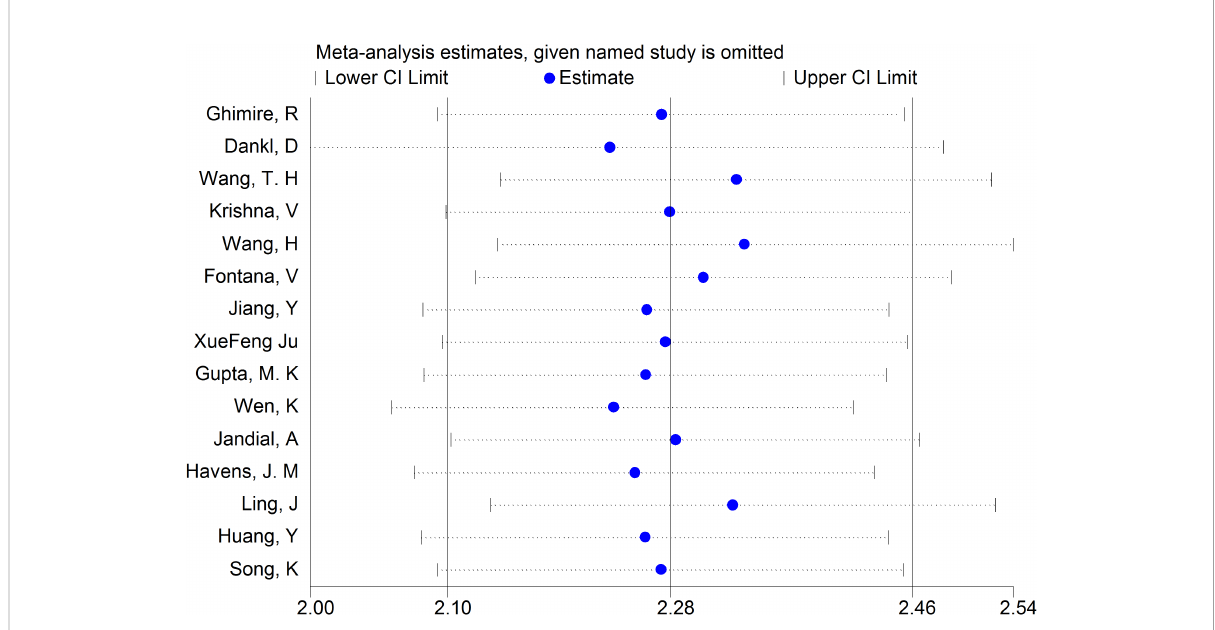
FIGURE 5 Sensitivity analysis of the result base on the new de fi nition and clinical criteria for sepsis (Sepsis-s and Sepsis-3). Also showed the lower and upper 95%